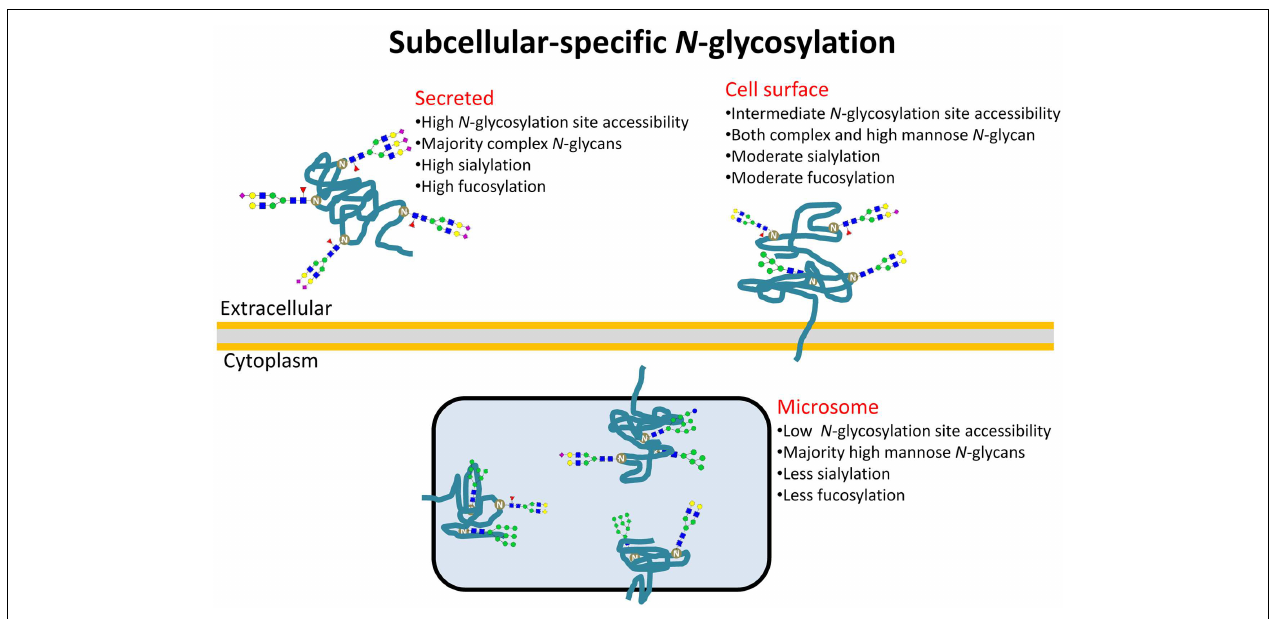
microsomal proteins receive high, intermediate, and low N -glycosylation processing, respectively, and as a result, display distinct glyco-determinant